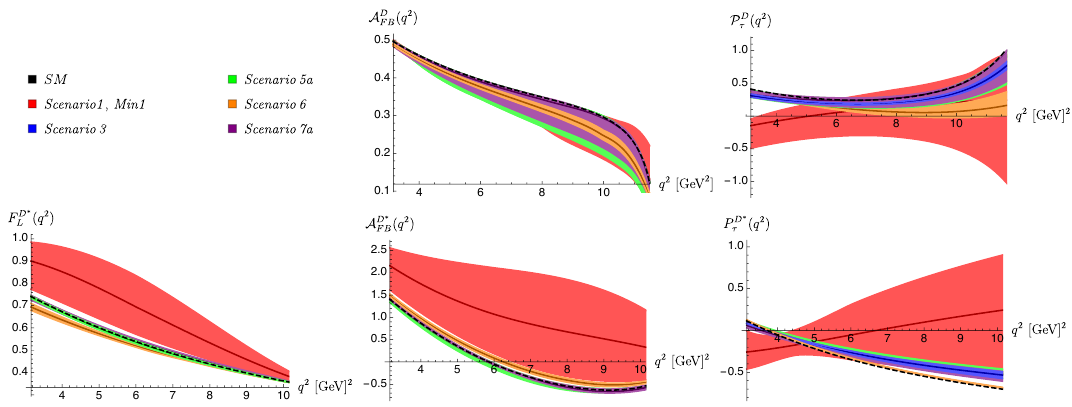
Figure 10 . Dependence on q 2 of the forward-backward asymmetries A D dinal polarizations P D ( (cid:3) ) and the longitudinal polarization fraction F D (cid:3) (cid:28) Figure 10 shows the predictions for the forward-backward asymmetries A D ( (cid:3) ) longitudinal D (cid:3) polarization F D (cid:3)